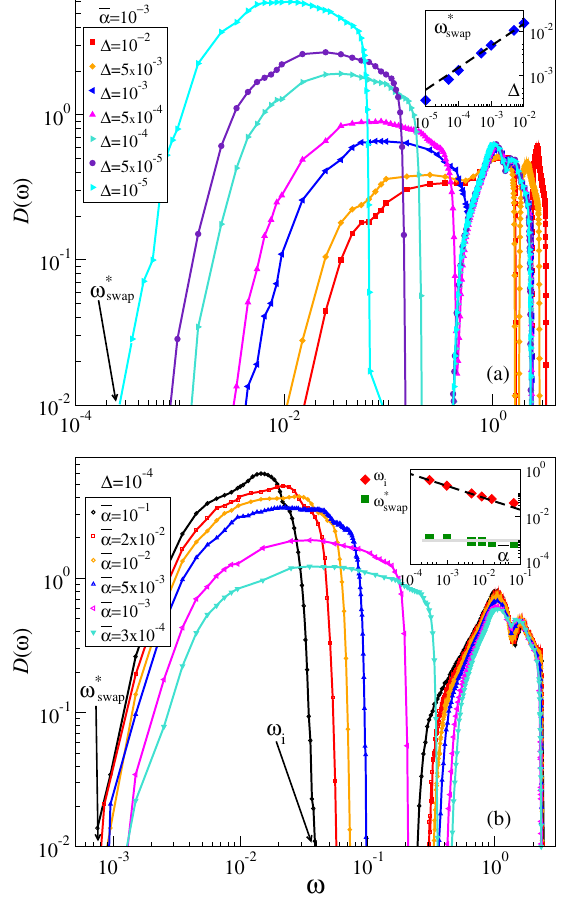
FIG. 4. (a) D ð ω Þ for different Δ at fixed ¯ α ¼ 10 − 3 . Inset: ω (cid:3) versus Δ , where ω (cid:3) line corresponds to the marginality condition ω (cid:3) (b) D ð ω Þ for different ¯ c and fixed Δ ¼ 10 − 4 . Inset: ω (cid:3) Δ . Dashed line is the theoretical prediction ω continuous line corresponds to ω (cid:3)